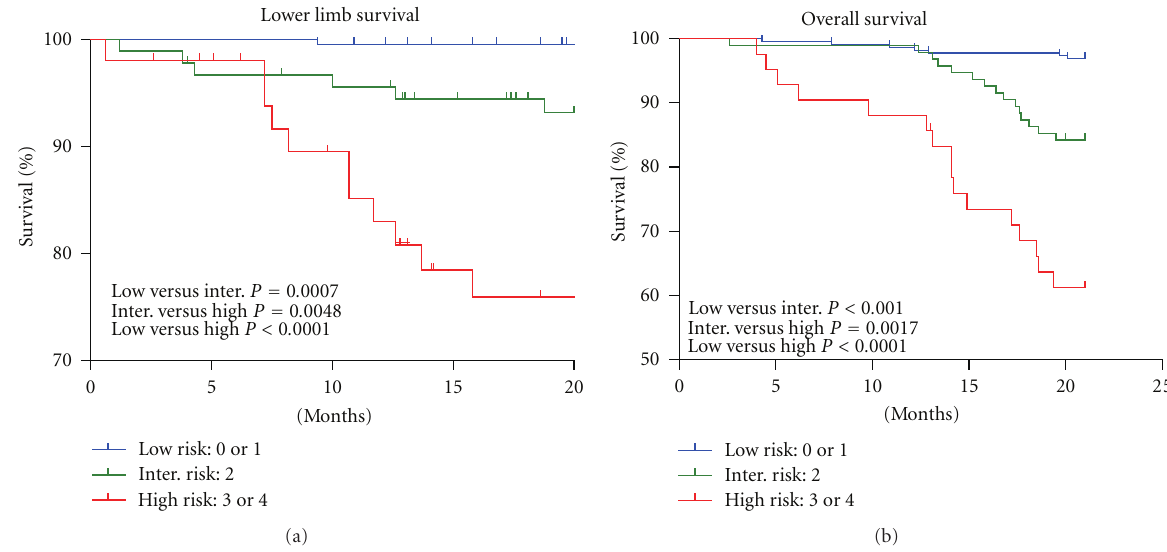
Figure 4: Lower limb survival and overall survival based on the risk classification. We categorized the three groups according to the number of risk factors based on a Cox regression analysis. Patients with zero or one risk factor, two risk factors, and three or four risk factors were regarded as the low-risk, intermediate-risk, and high-risk groups, respectively. Lower limb survival and overall survival were significantly lower in the high-risk group than in the other groups.